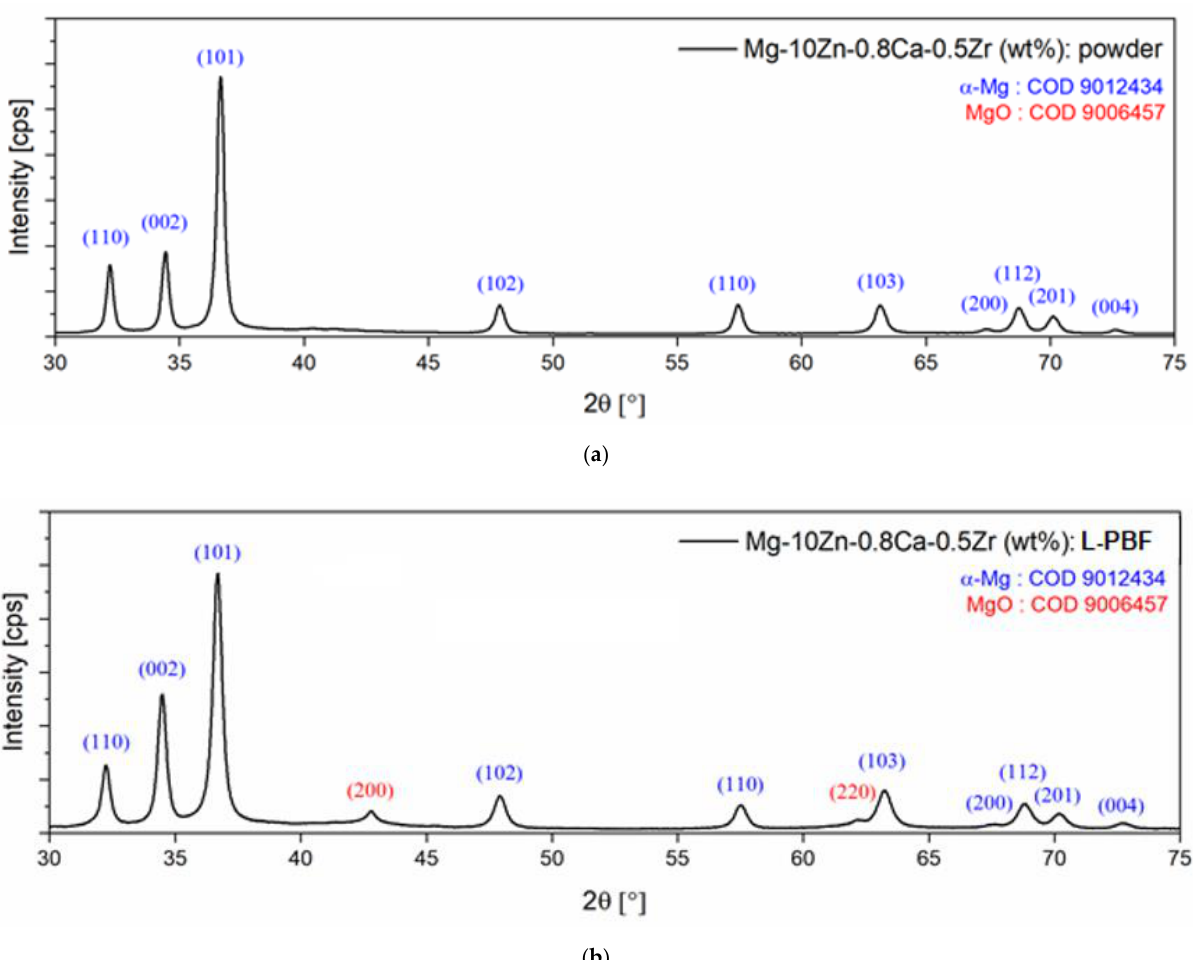
Figure 10. XRD images of the Mg-10Zn-0.8Ca-0.5Zr alloy: ( a ) the initial powder alloy; ( b ) the L-PBF-processed